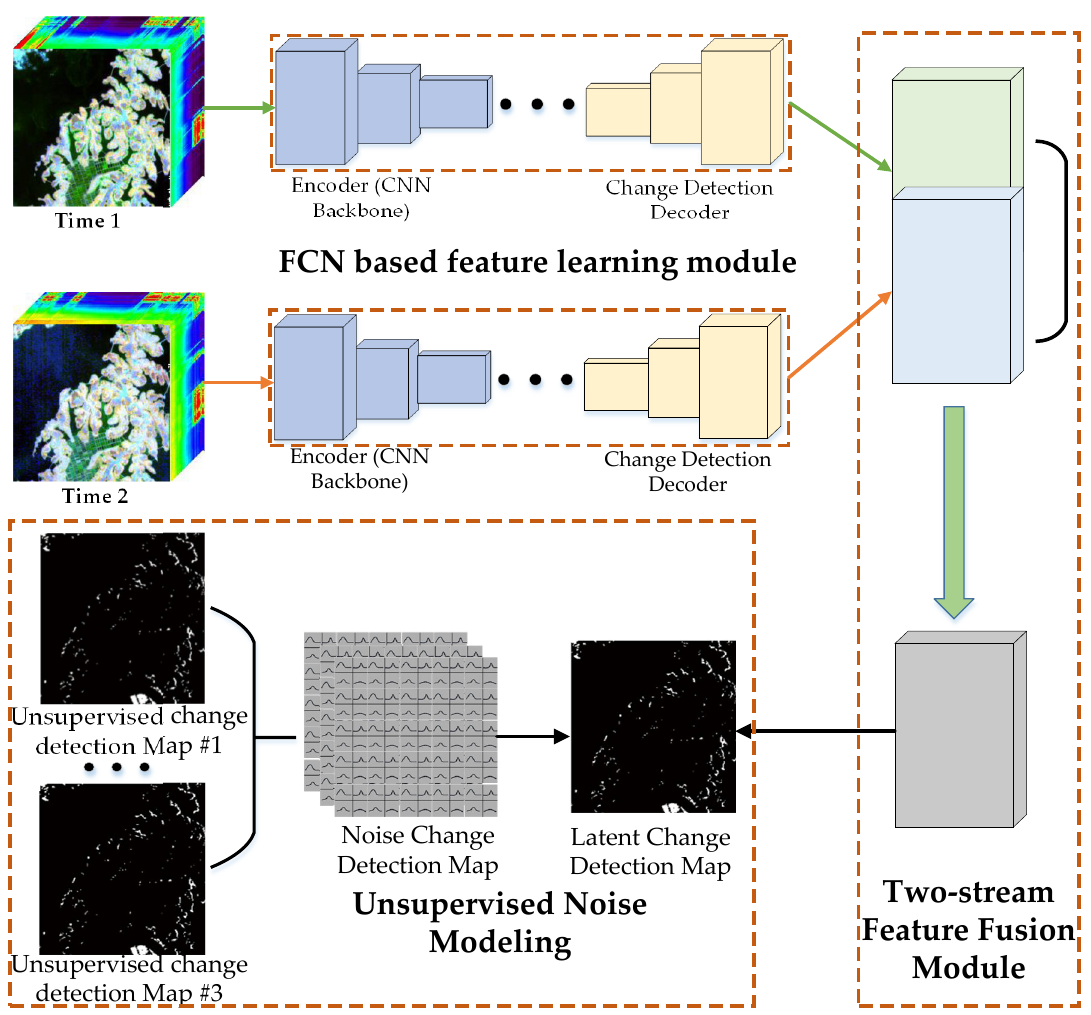
Figure 1. The illustration of the proposed change detection framework, which consists of an fully convolutional network (FCN)-based feature learning module, a two-stream feature fusion module, and an unsupervised noise modeling